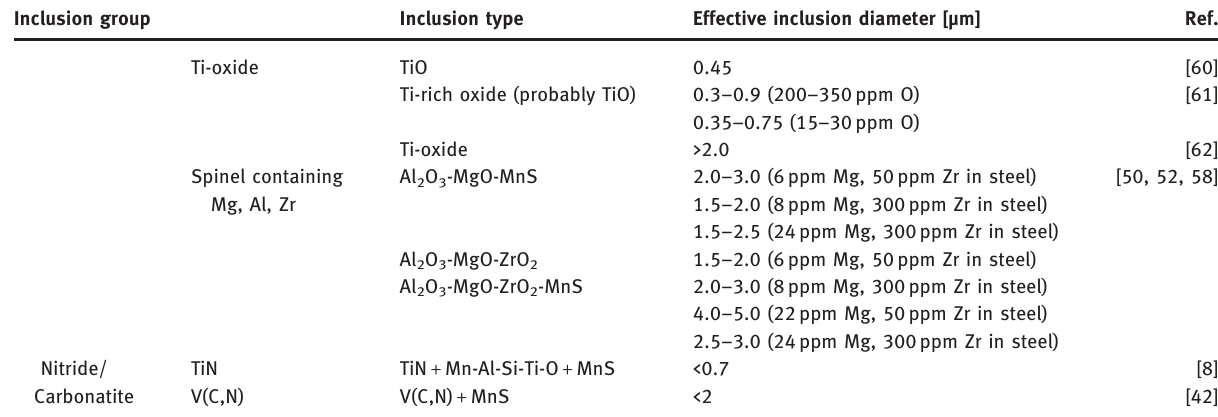
Table 1: Summary of experimental studies of effective inclusion size for IGF nucleation. Inclusion